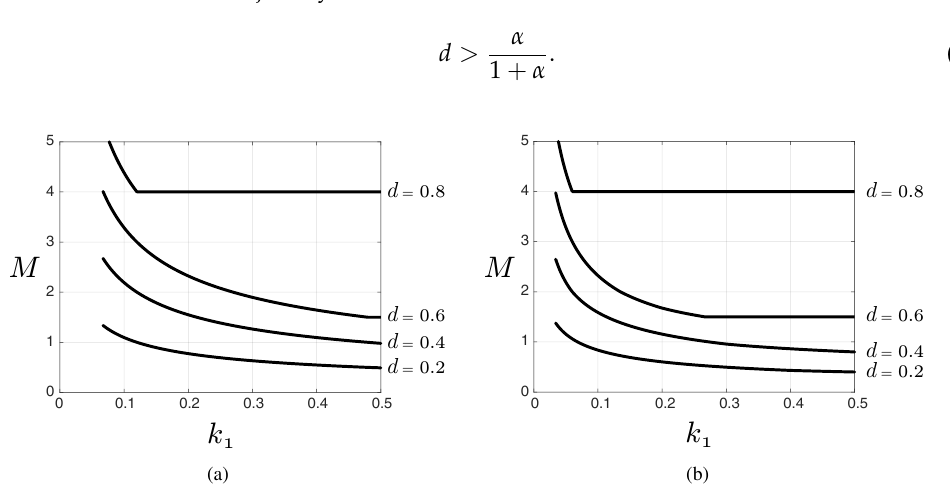
Figure 8. Families of open-loop characteristic curves with constant duty cycles: ( a ) case α = 1 ( b ) case α =